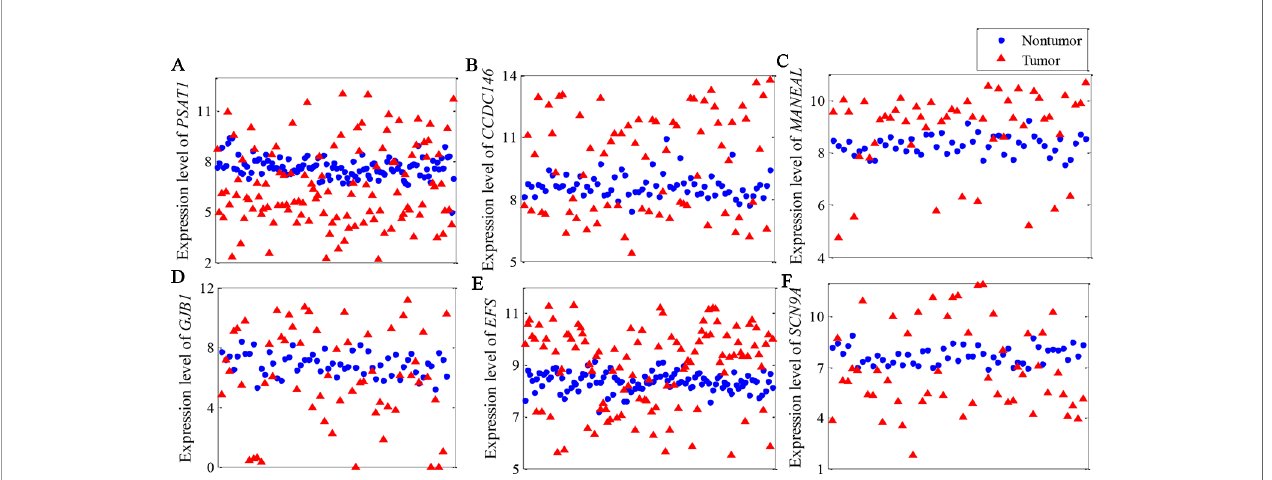
FIGURE 4 | Expression pattern of top gene highlighted by the normalized differential correlation (NDC) measure for each dataset. (A) BRCA, (B) KIRC, (C) LIHC, (D) LUAD, (E) LUNG, (F) LUSC.